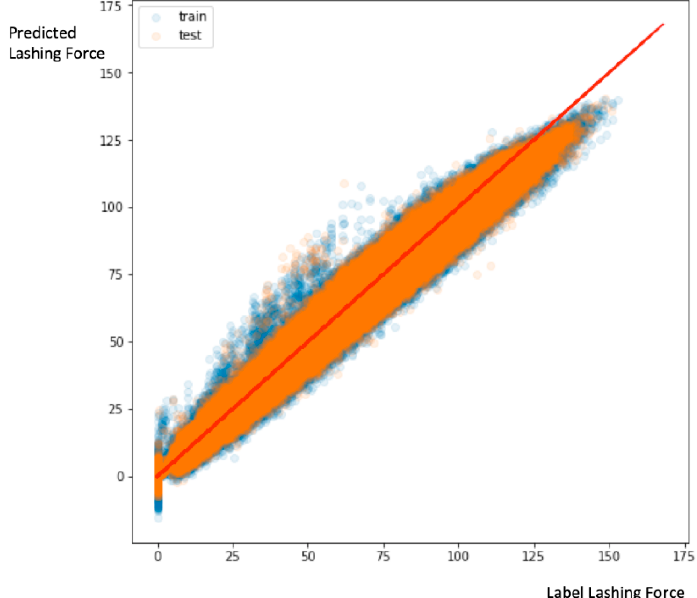
Figure 10. Overall test rResult against training result. X axis = label, Y axis = predicted value, blue dot = training result, orange dot = test result.